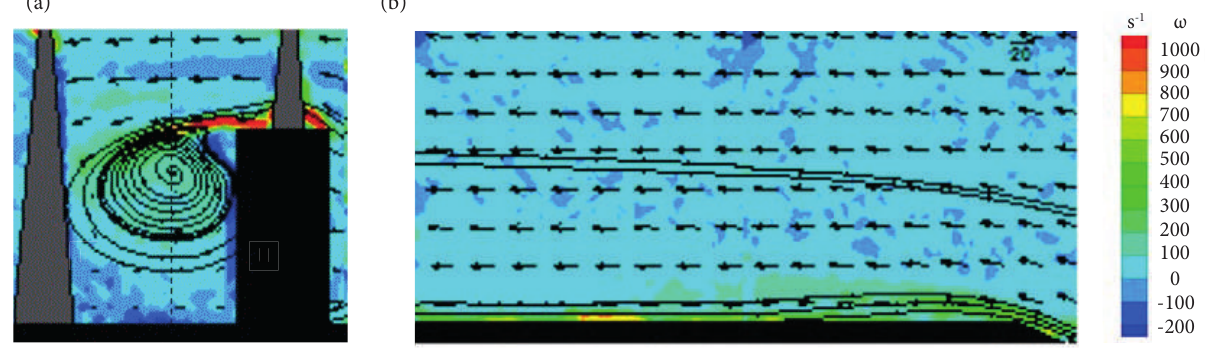
Figure 19. Vorticity contours and velocity vectors – β = 45°, α = 45° and Re = 4.3 × 10 5 .